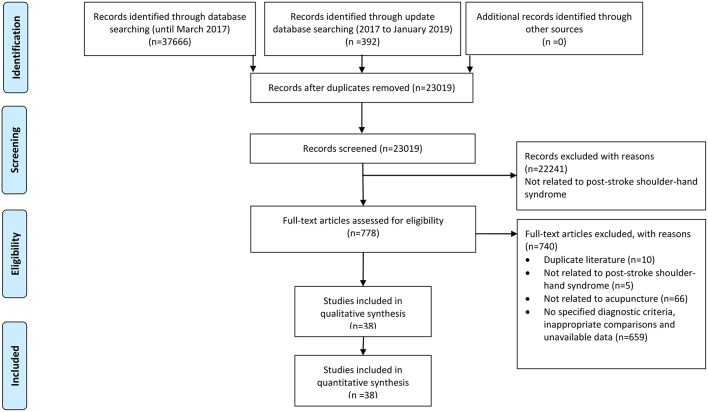
PRISMA flow chart.